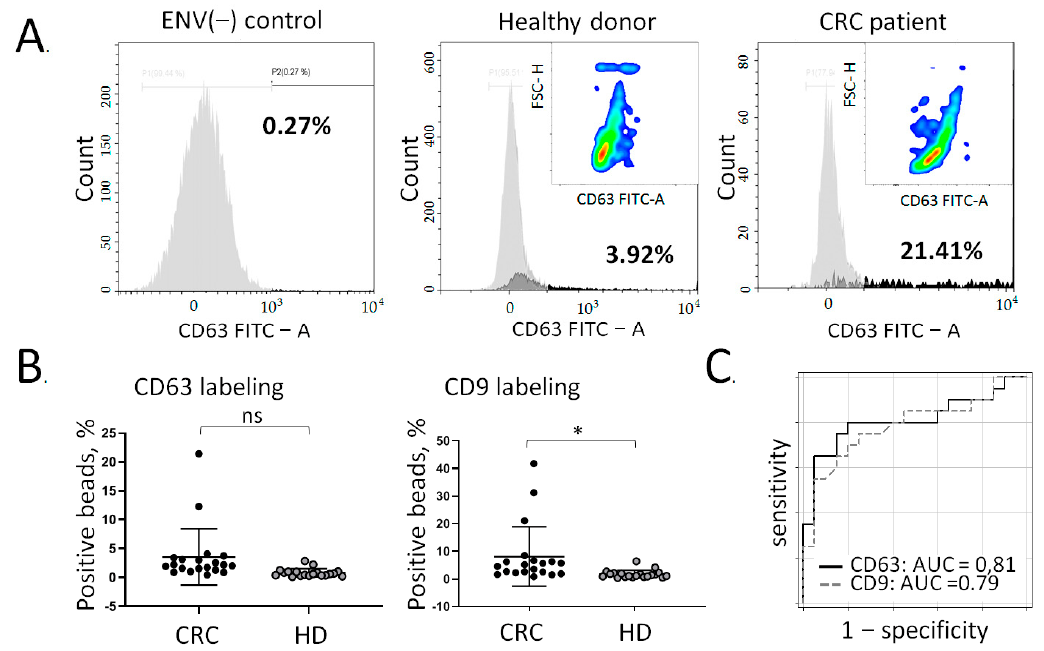
Figure 3. Quantitative analysis of MeprinA(+)ENVs in the plasma of CRC(IIIb-IV) patients and healthy donors. The total population of ENVs was isolated with PTPS, and the fraction of Meprin(+)ENVs was isolated using immune-beads decorated with antibodies against Meprin A. Captured MeprinA(+)ENVs were labeled with antibodies against the exosomal markers CD63 and CD9 and quantified by flow cytometry. ( A ) Representative examples of flow cytometry histograms after labelling with anti-CD63 antibodies (FITC signals). The colored inserts present pseudo-color/smooth plots of positive events. Lower panels: higher magnification. ( B ) Group comparison of CRC (IIIb-IV) patients (n = 20) vs. healthy donors (n = 20) after labelling with anti-CD63 or anti-CD9 antibodies. The statistical significance was estimated using nonparametric Mann-Whitney test (ns > 0.05; * p < 0.05). ( C ) Evaluation of the diagnostic potency of this method by receiver operating characteristic (ROC) analysis in the same group of samples.